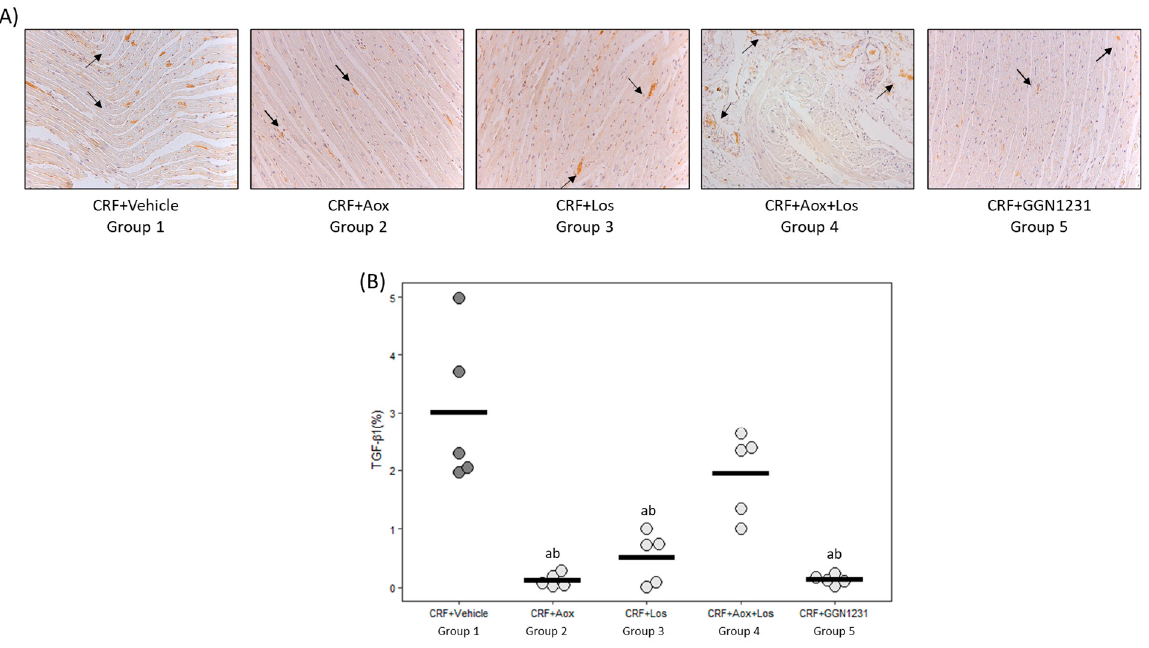
Figure 6. Protein expression of TGF- β 1 by immunohistochemistry. ( A ) Representative photo of TGF- β 1 immunohistochemistry (20×). ( B ) Arrows point to TGF- β 1 protein expression Quantification of TGF- β 1 immunohistochemistry in all groups. CRF (chronic renal failure); Aox (antioxidant); Los (losartan); Aox+Los (antioxidant plus losartan); GGN1231 (antioxidant plus losartan hybrid). Data represent mean values per group in horizontal lines in the bee swarm graphic. a p < 0.05 versus CRF+vehicle; b p < 0.05 versus